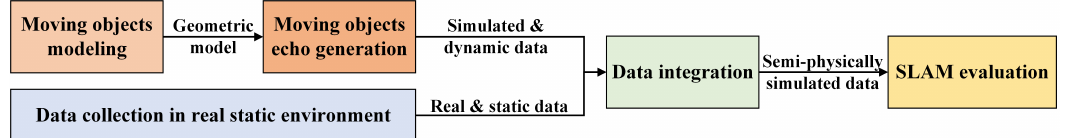
Figure 1. Semi-physical simulation-based LiDAR-SLAM